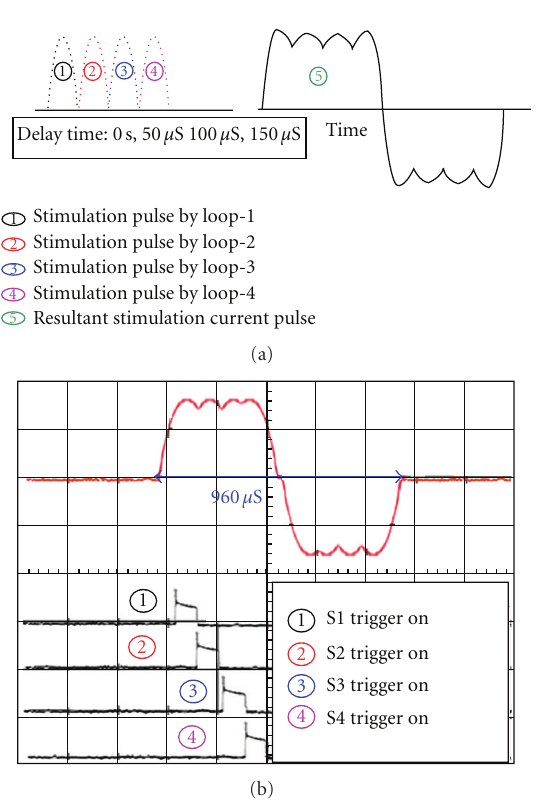
Figure 5: (a) Idea, (b) test. S1 → S2 → S3 → S4: trigger on (delay: 0s, 50 μ S, 100 μ S, 150 μ S; pulse width: 960 μ